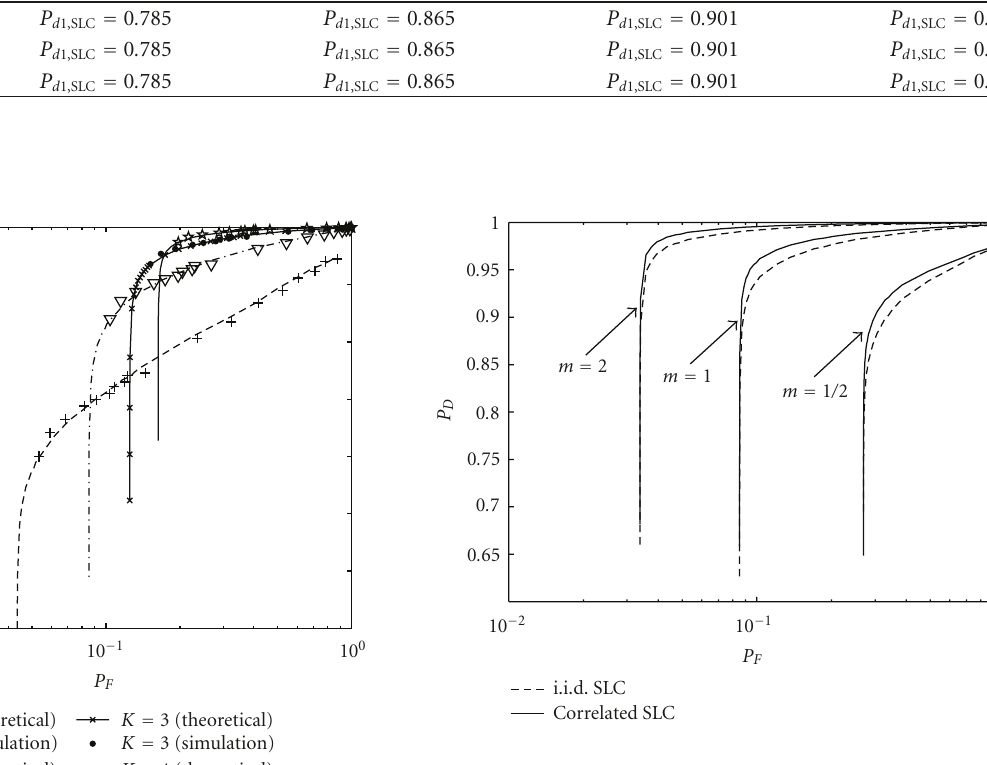
Figure 6: P D versus P F for K = 2 employing Dual SLC for both i.i.d. and correlated ( ρ = 0 . 7) diversity branches, γ = 10 dB.